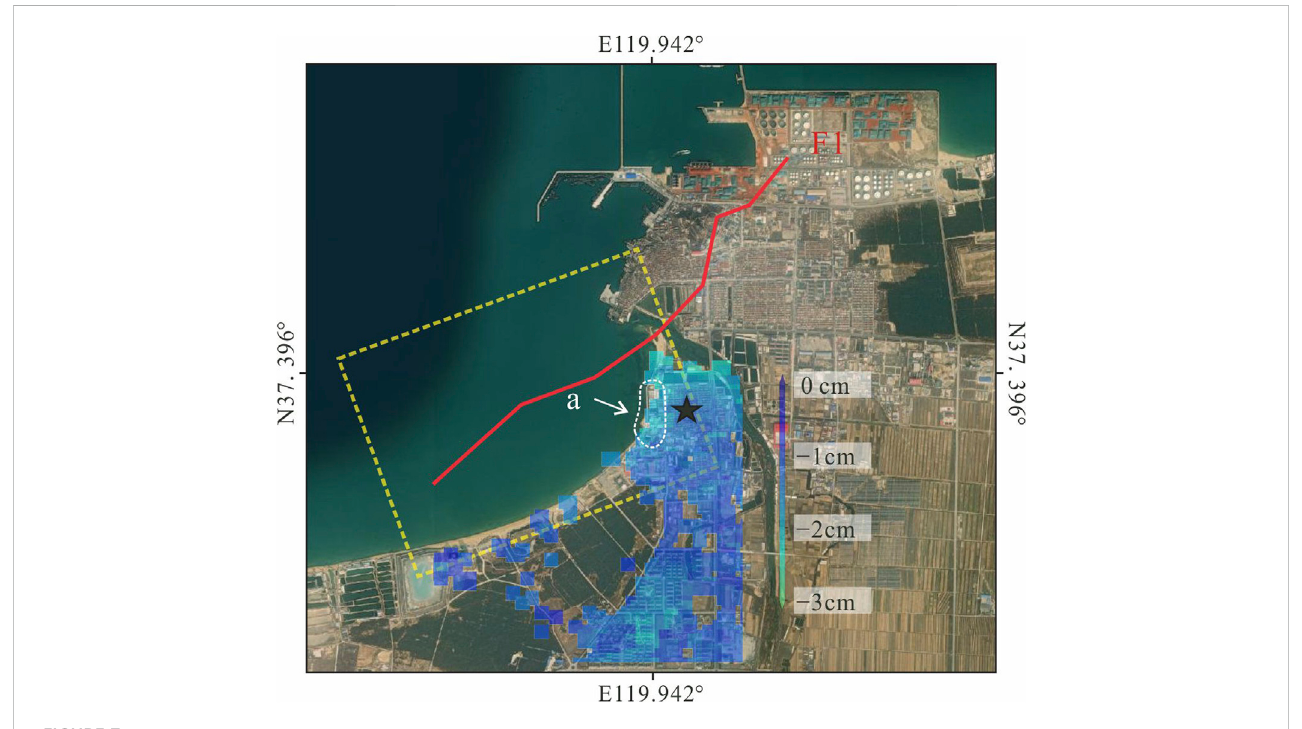
FIGURE 7 Spatial characteristics of the LOS displacement fi eld (PSI result).